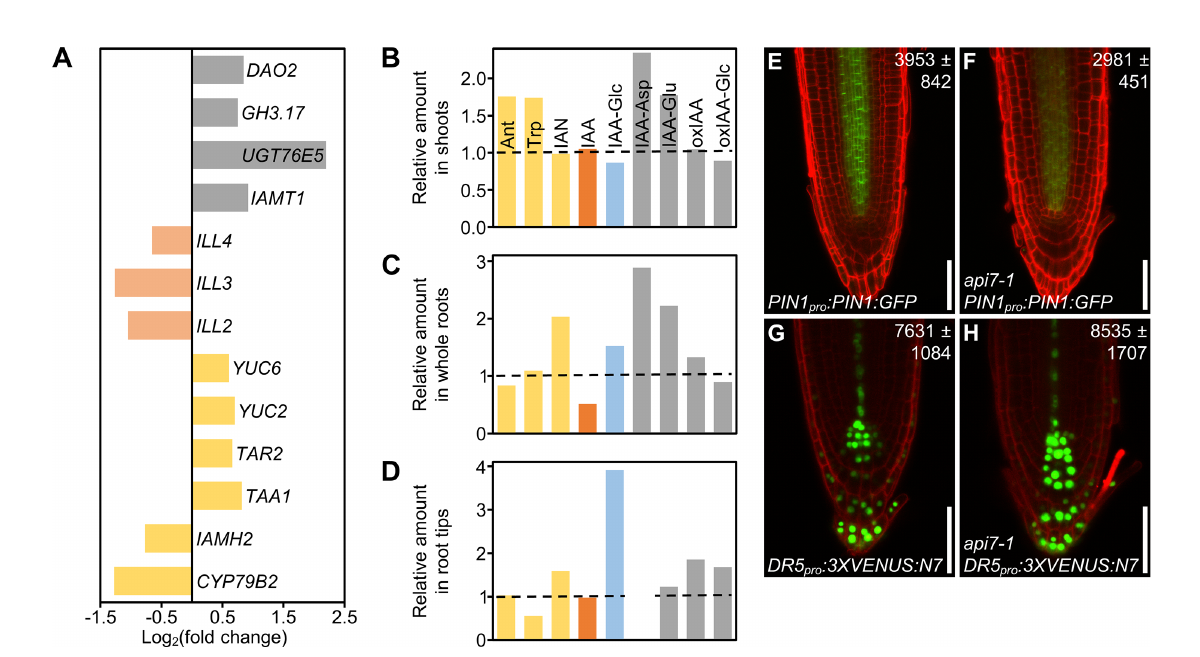
FIGURE 6 Auxin metabolism, transport and signaling are altered in api7-1 plants. (A) Expression levels of genes related to auxin metabolism (biosynthesis, yellow; activation, pale orange; storage and catabolism, grey) in api7-1 shoots 14 das. Values are shown as the binary logarithm of the fold change between api7-1 and L er mean reads. Mean reads were calculated from three biological replicates. (B – D) Relative amounts of some IAA precursors (yellow; Ant, anthranilate; Trp, tryptophan; IAN, indole-3-acetonitrile), IAA (orange), the IAA storage molecule IAA-Glc (glycosylated IAA; blue), and IAA catabolites (grey; IAA-Asp and IAA-Glu, IAA conjugated to aspartate and glutamate, respectively; oxIAA, 2-oxindole-3-acetic acid; oxIAA-Glc, glycosylated 2-oxindole-3-acetic acid) in api7-1 (B) shoots, (C) whole roots, and (D) root tips 9 das. IAA-Asp was not detected in root tips. The mean amounts of each metabolite in L er were used as the reference value (dashed lines; see Supplementary Figure S14). Mean amounts were calculated from four biological replicates. (E – H) Visualization of the expression of reporter transgenes for auxin (E, F) transport and (G, H) perception, in (E, G) wild-type and (F, H) api7-1 roots. Cell walls were stained with propidium iodide. Values indicate average fl uorescence intensities ± standard deviation from (E, F) GFP and (G, H) VENUS, which are signi fi cantly different from the wild type in a Student ’